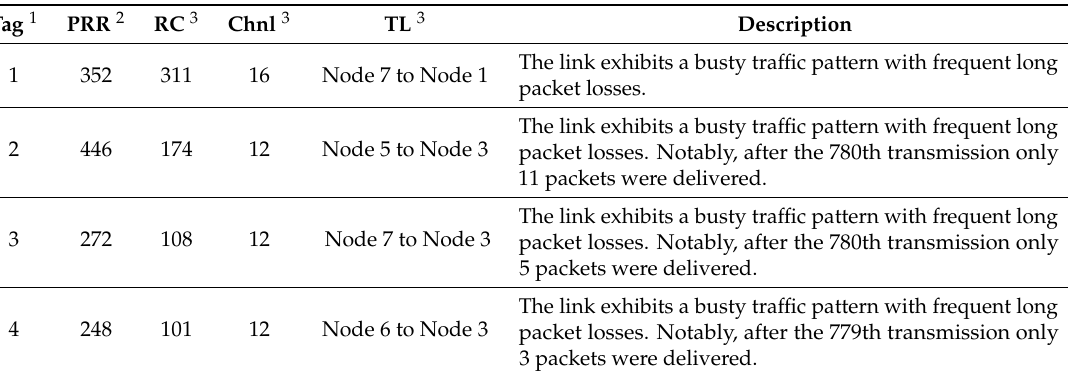
Table 2. Diagnosis results of the